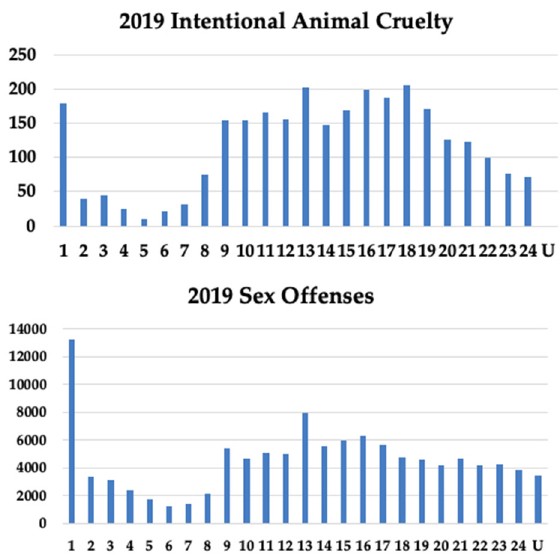
Figure 11. Time of Day for 2019 Intentional Animal Cruelty and Sex Offenses.